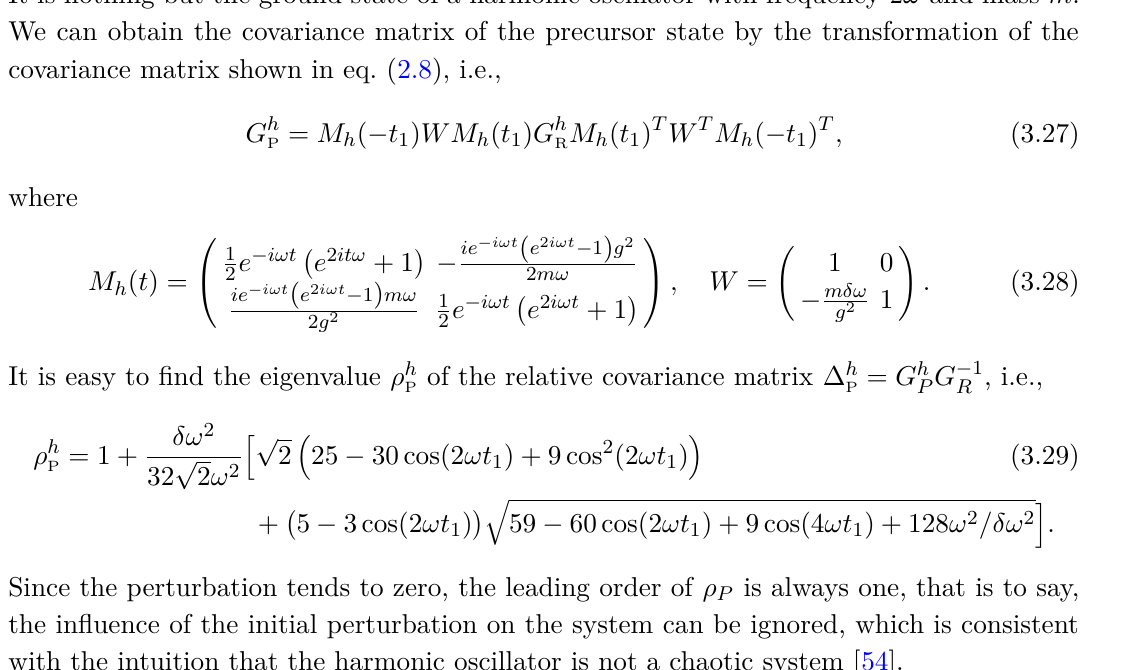
Figure 5 . log ρ and log ρ 0 vs time for the figure on the left. Relative error (log ρ 0 P P vs time for the figure on the right. The parameters are set as ωt s = ωt f = 20 , δω/ω = 10 − 3 . It is nothing but the ground state of a harmonic oscillator with frequency 2 ω and mass m